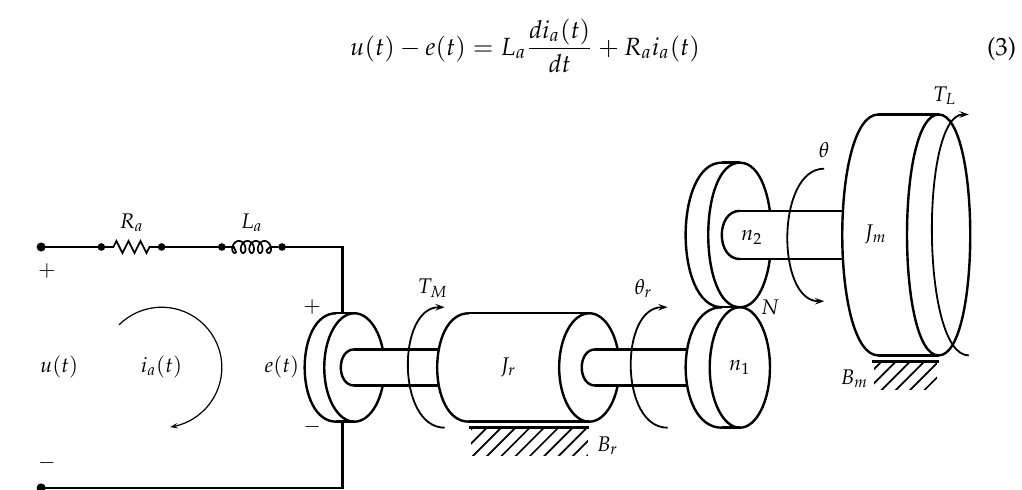
Figure 2. Electromechanical plant schematic